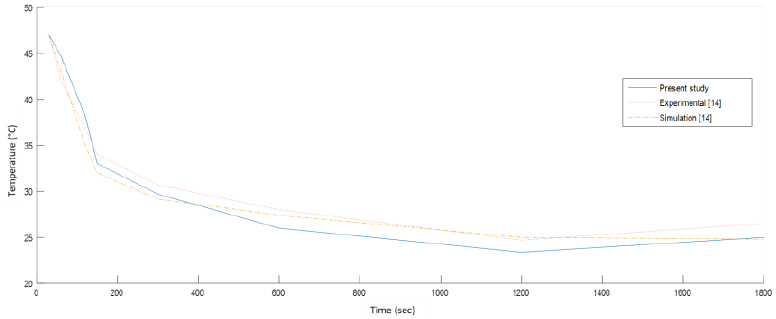
Energies 2020 , 13 , x FOR PEER REVIEW Figure 5. Results validation for the cooling down process. Figure 5. Results validation for the cooling down process.